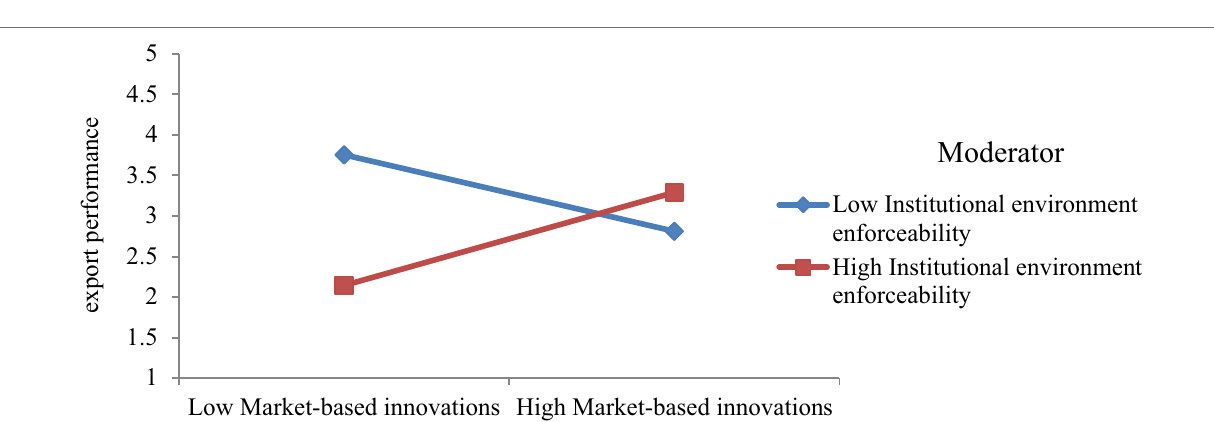
FIGURE 9 | Moderating effect of institutional environment enforceability on market-based innovation–export performance link. * p < 0.05; ** p < 0.01; *** p < 0.001.